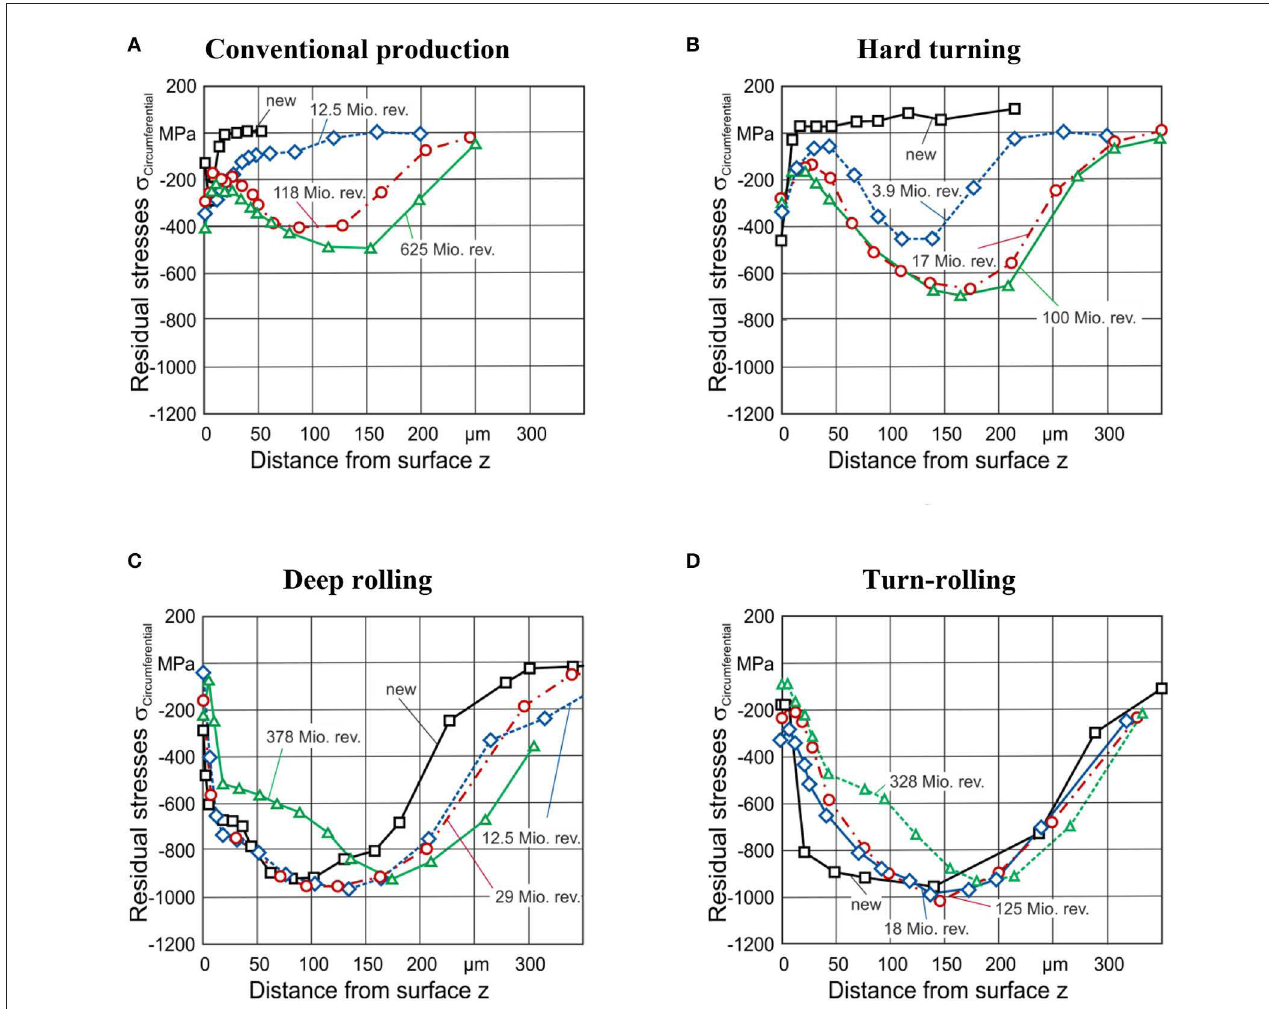
FIGURE 4 | Comparison of residual stress depth profiles at different running times depending on the respective production strategy for NU206 inner rings and a bearing load of C/P = 4. (A) Reference from conventional large series production, (B) Hard turning, (C) Hard turning with subsequent deep rolling, (D) Combined